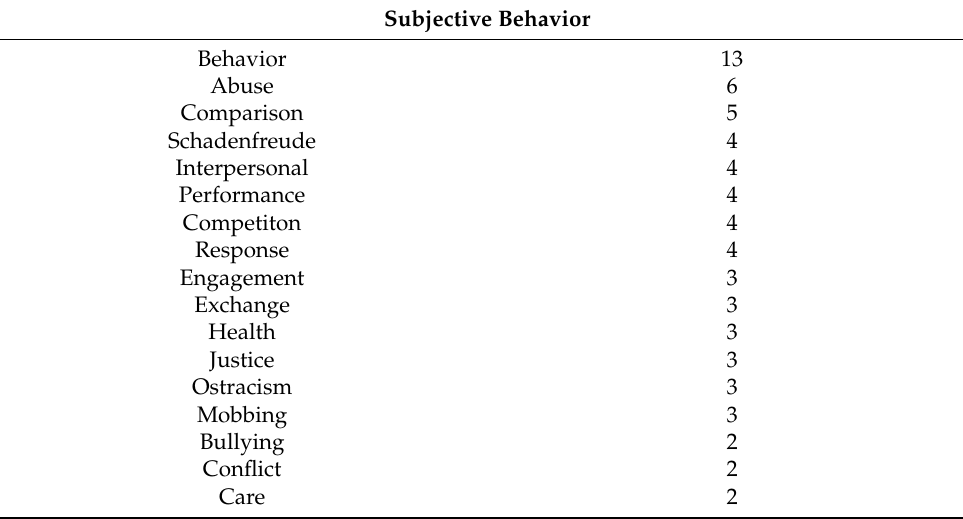
Table 5. Frequency and categories of subjective behavioral studies on the relationship between leadership and envy.